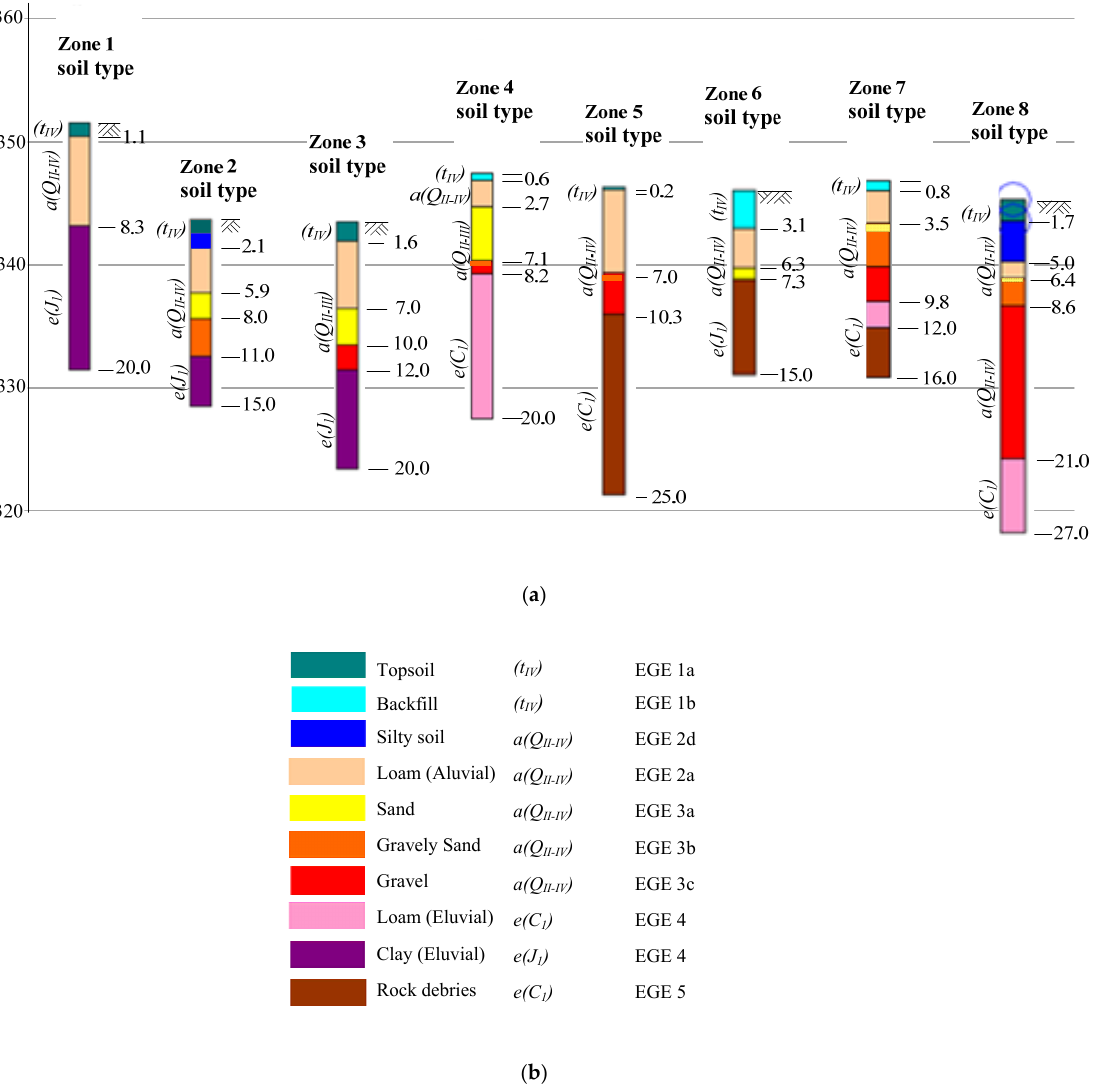
Table 3. Physical and mechanical characteristics of the soil layers in Zone 1.